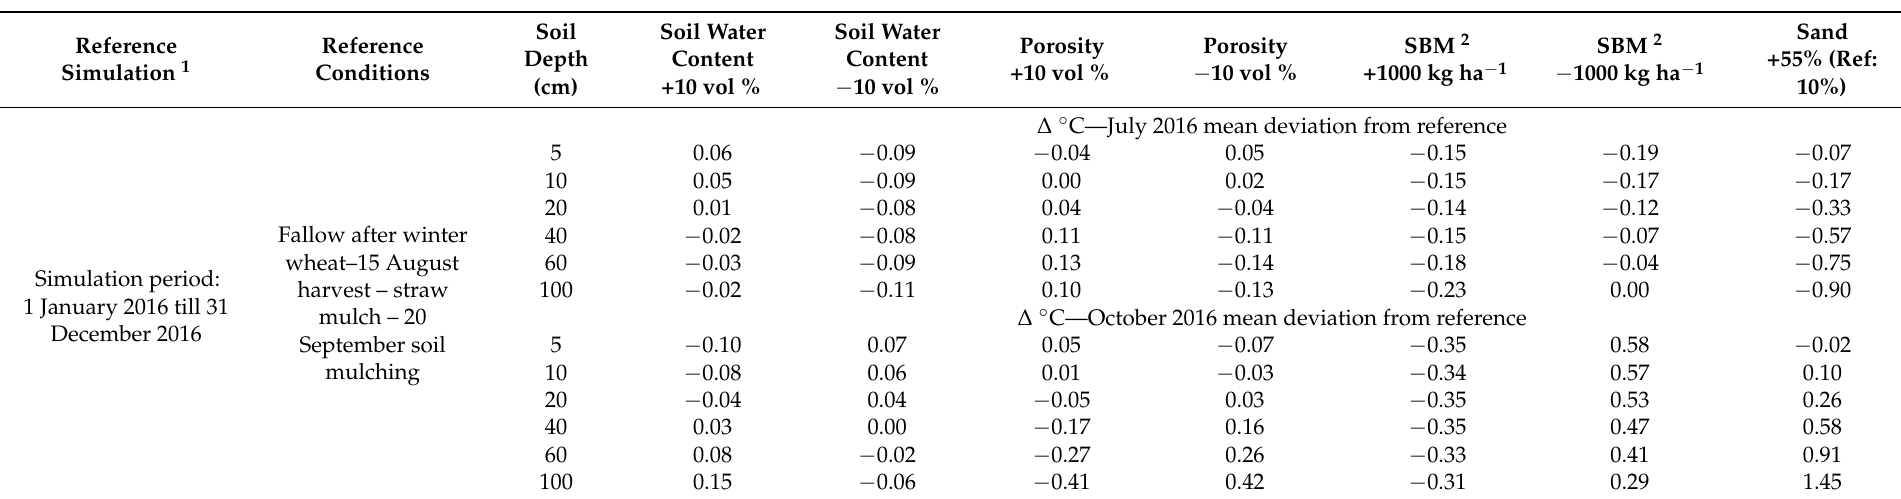
Table 6. Basic model sensitivity analysis of the effect of the main important model input parameters on simulated soil temperature at the Goggendorf validation site (see also Table 4).